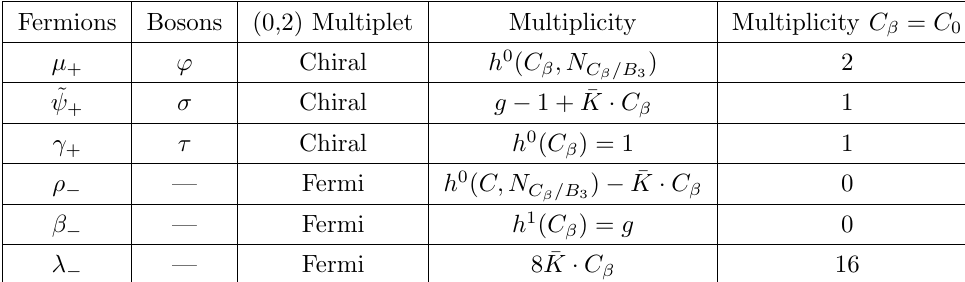
Table 1 . 2d (0 ; 2) multiplets in the e(cid:11)ective theory on R 1 ; 1 (cid:2) C (cid:12) , where C (cid:12) is a curve of genus g with normal bundle N inside the base B 3 of Y 4 (this is based on table 5 in [115]). The C (cid:12) =B 3 subscripts of the fermions denote the chirality along the string